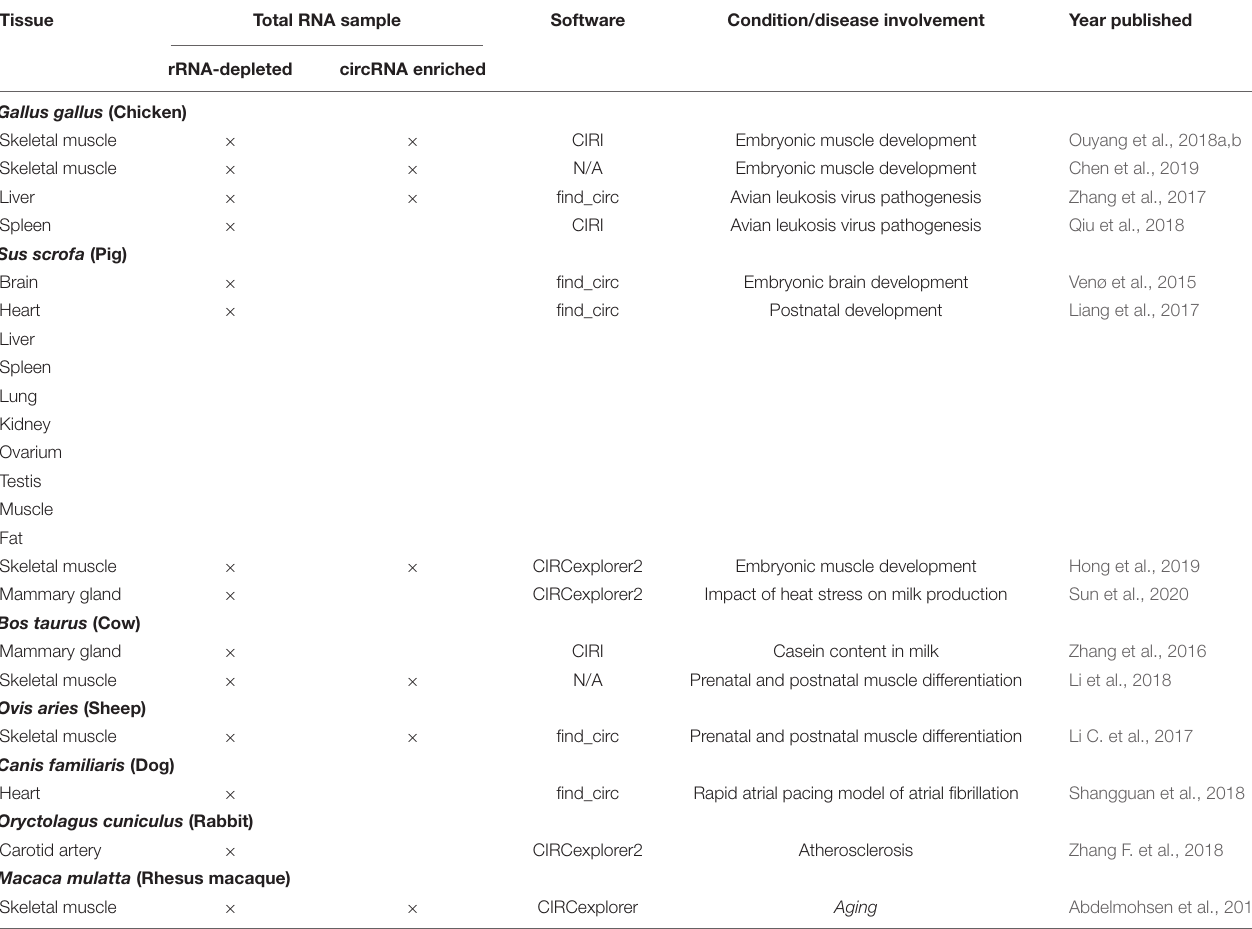
TABLE 3 | Summary of variables in studies of circular RNAs in non-rodent animal